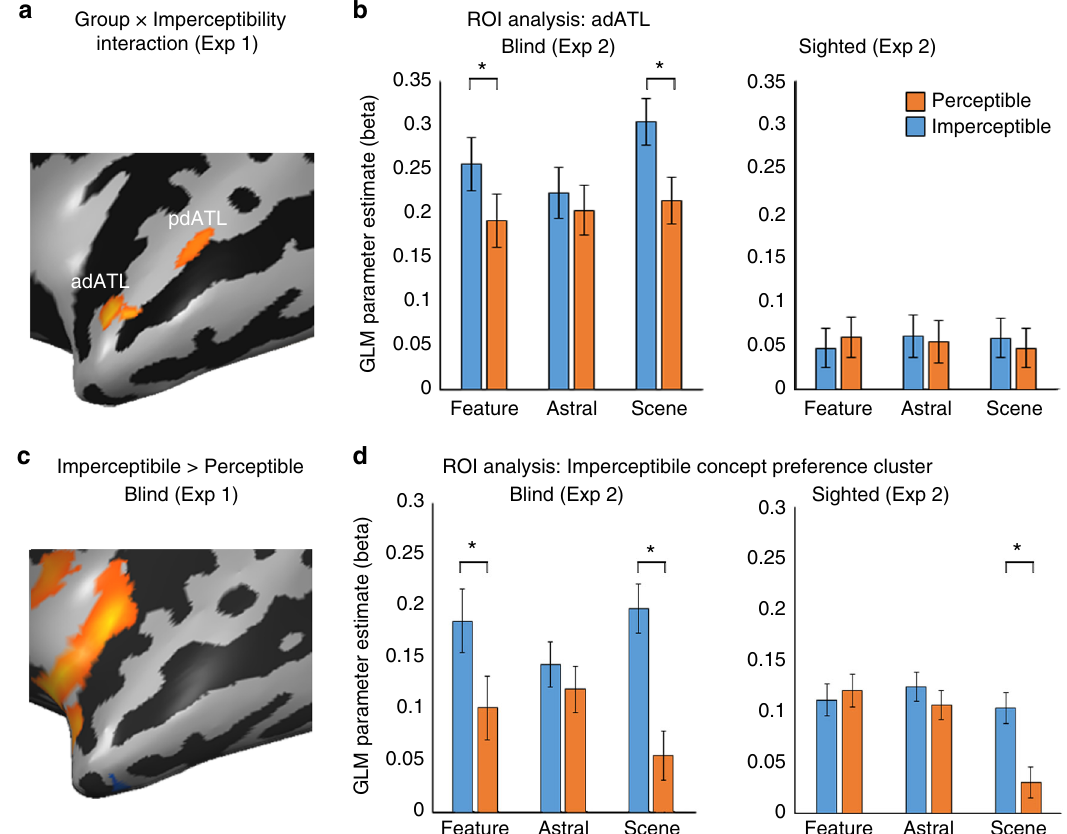
Fig. 2 Imperceptible concepts processing is supported by the left dorsal ATL. a To probe for the effect of sensory feature perceptibility, we compared brain activity in people blind from birth and sighted controls, in response to concepts which have external referents in the world, but are perceptible only through the visual sensory modality, and are thus imperceptible to a blind person (e.g. “ rainbow ” ) as compared to concepts whose referents are sensorially perceptible also to the blind (through other modalities; e.g., “ rain ” ). An area which is sensitive to imperceptibility of concepts should respond differently in the two groups for this contrast, as visually-dominant concepts are fully perceptible to the sighted subjects. The ANOVA effect of Group X